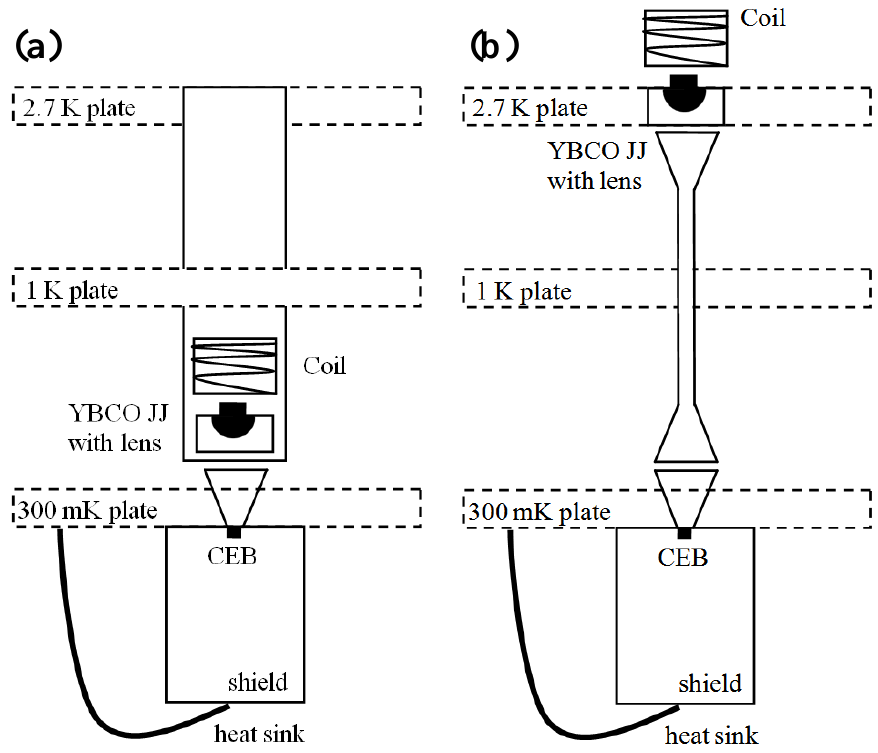
Figure 2. Schematic representation of two setups with closer ( a ) and remote ( b ) placement of YBCO Josephson generators for the study of the amplitude-frequency characteristics of